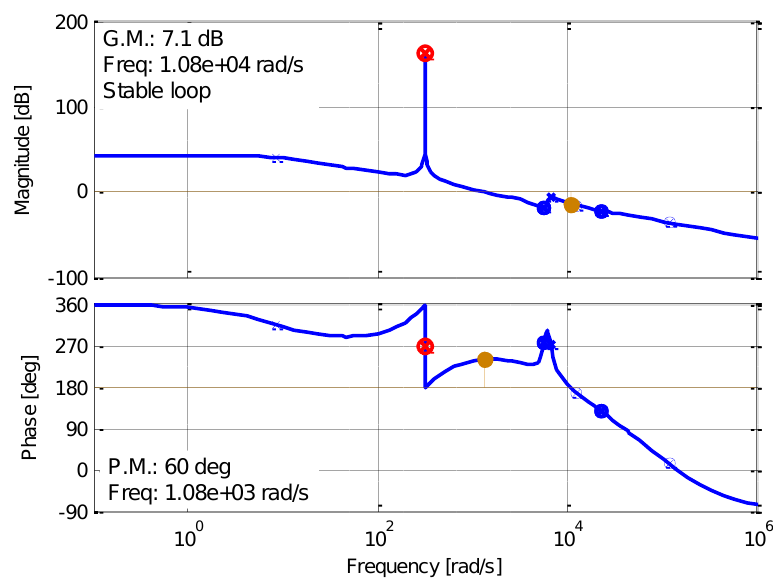
Figure 7. Bode diagram of the open-loop system under the selected gains.